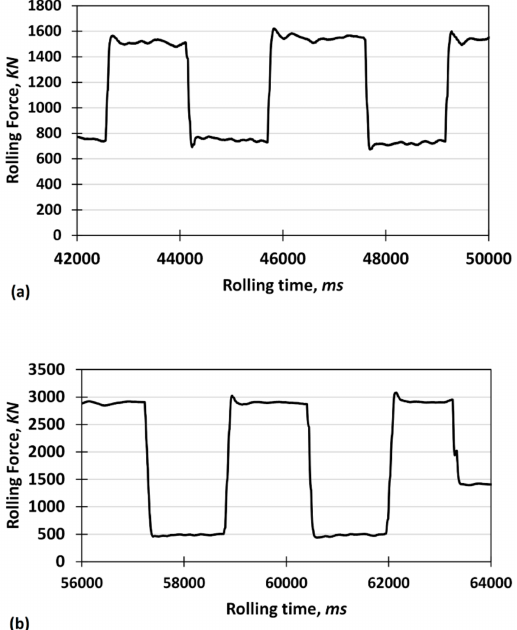
Figure 3. Rolling force vs. rolling time curves for ( a ) absolute thickness reduction of 0.2 mm and ( b ) absolute thickness reduction of 1 mm.